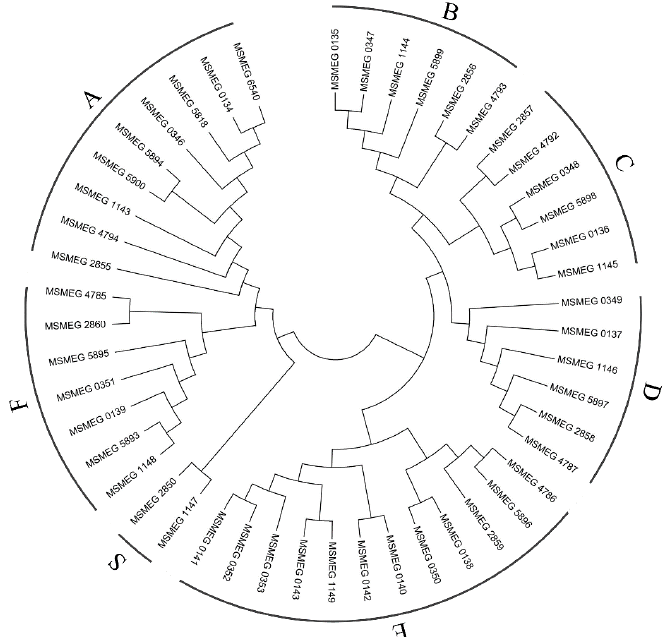
Figure 4. Phylogenetic analysis of 48 mammalian cell entry (MCE) related proteins. Protein sequences were deduced from 48 MCE related genes. Phylogenetic tree was constructed using the Neighbor–Joining method in MEGA6 program [43]. Group A, B, C, D, E, F are consisted of MCE A , B , C , D , E , F genes, respectively, group S means an additional group.